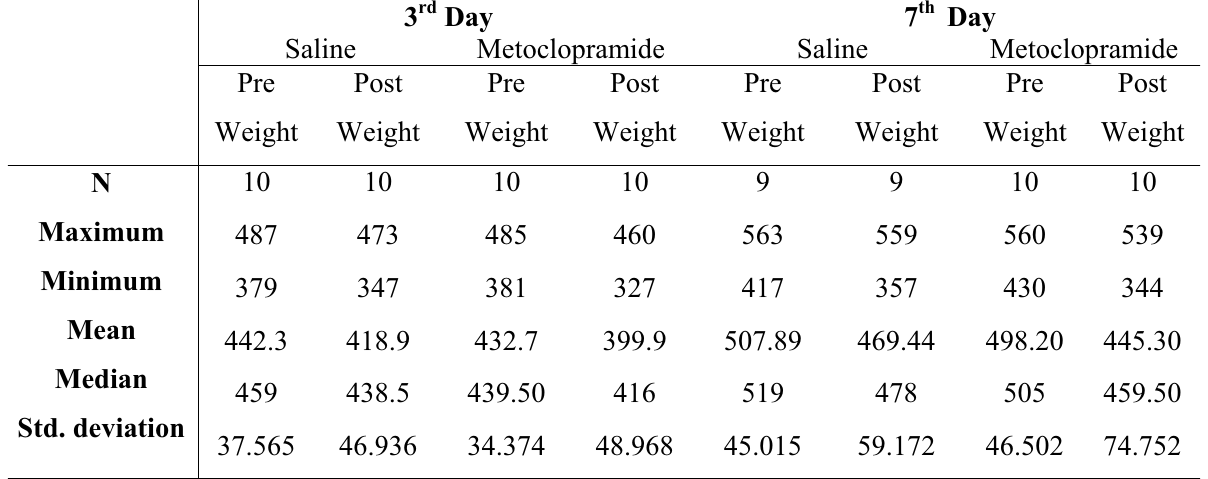
TABLE 1 - Weight in grams in the preoperative period (pre weight) and postoperative (post weight)